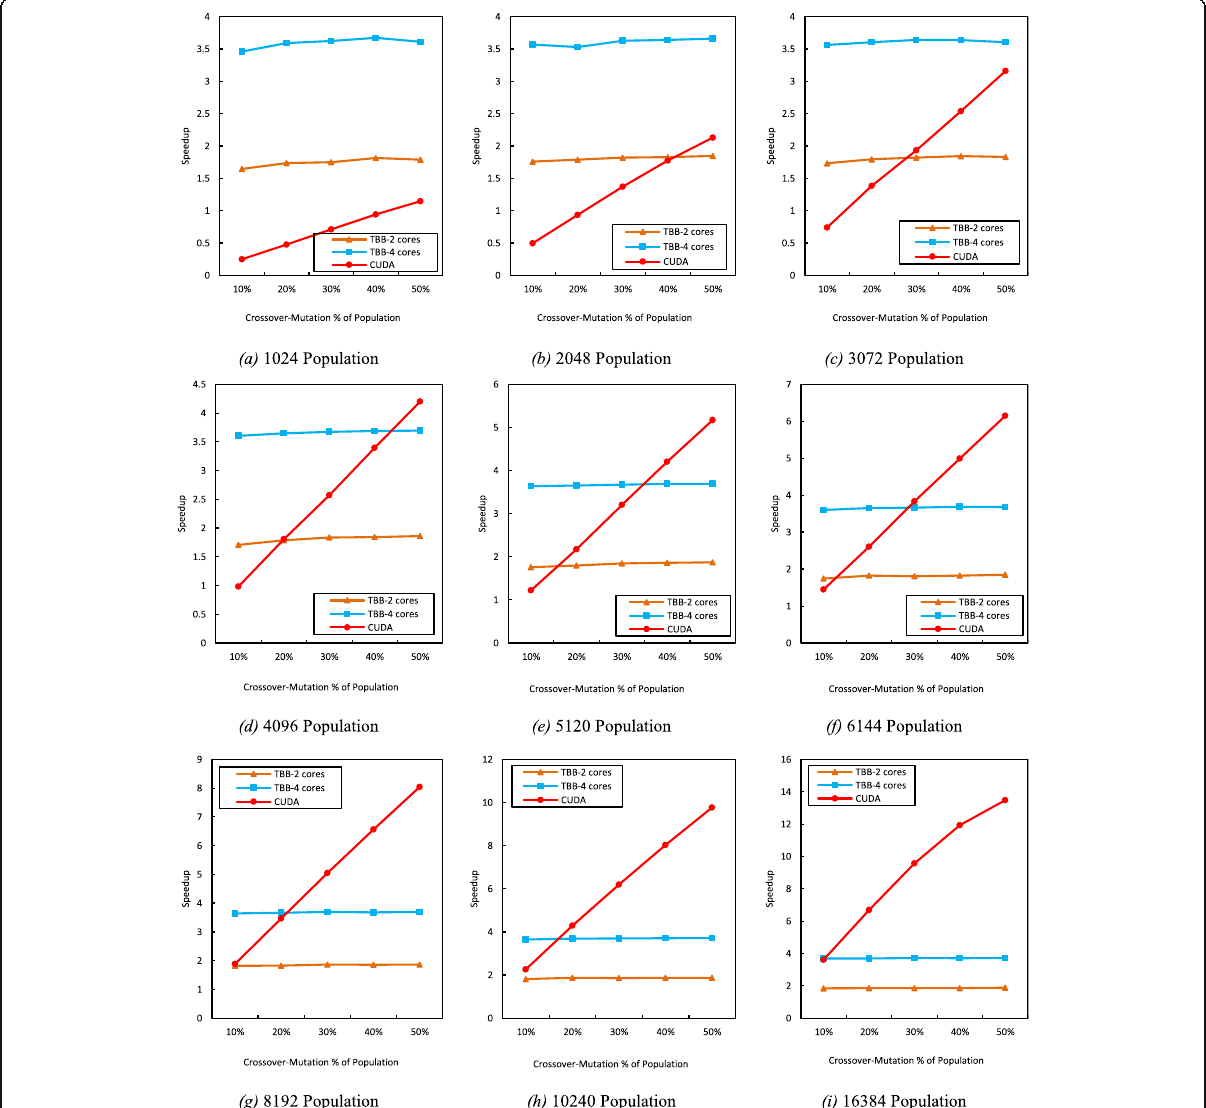
Fig. 7 The speedup of the parallel methods with respect to different ratios of offspring on different populations in a TSP with 380 cities. Each subplot is labeled with the corresponding population